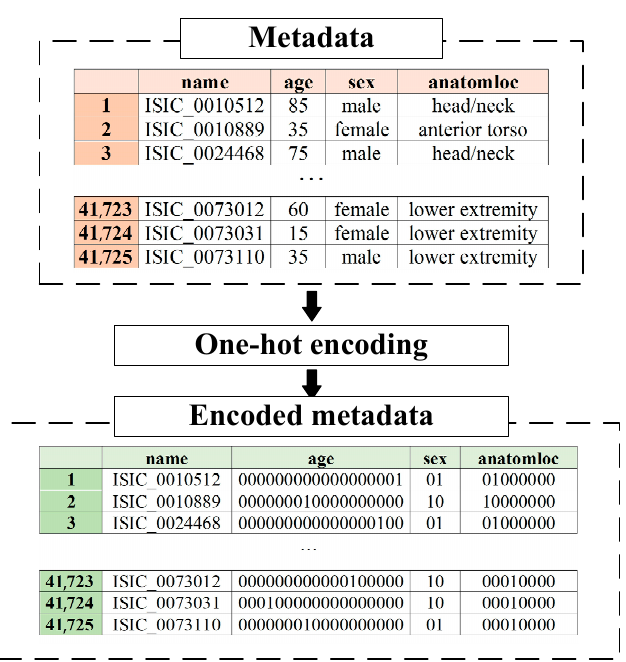
Figure 10. An example of pre ‐ processing statistical patient metadata using one ‐ hot encoding.